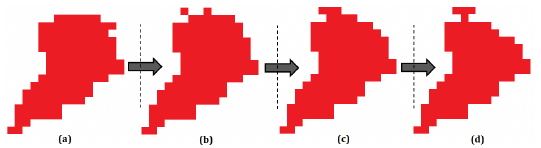
Figure 6. Change in spatial distribution of the Tropical cli- mate zone (A1) in Eastern India : (a) 1901-1925 , (b) 1926-1950 ,